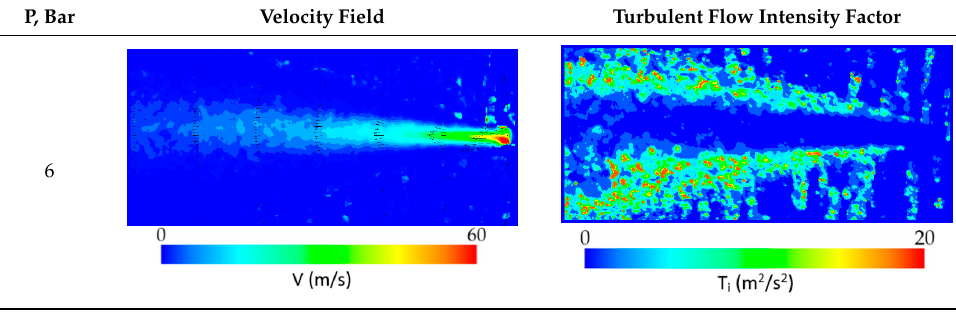
Table 4. Influence of pressure P supplying the nozzle on the character of velocity and turbulent flow intensity factor fields for stub regulation angle α = 0°. P, Bar